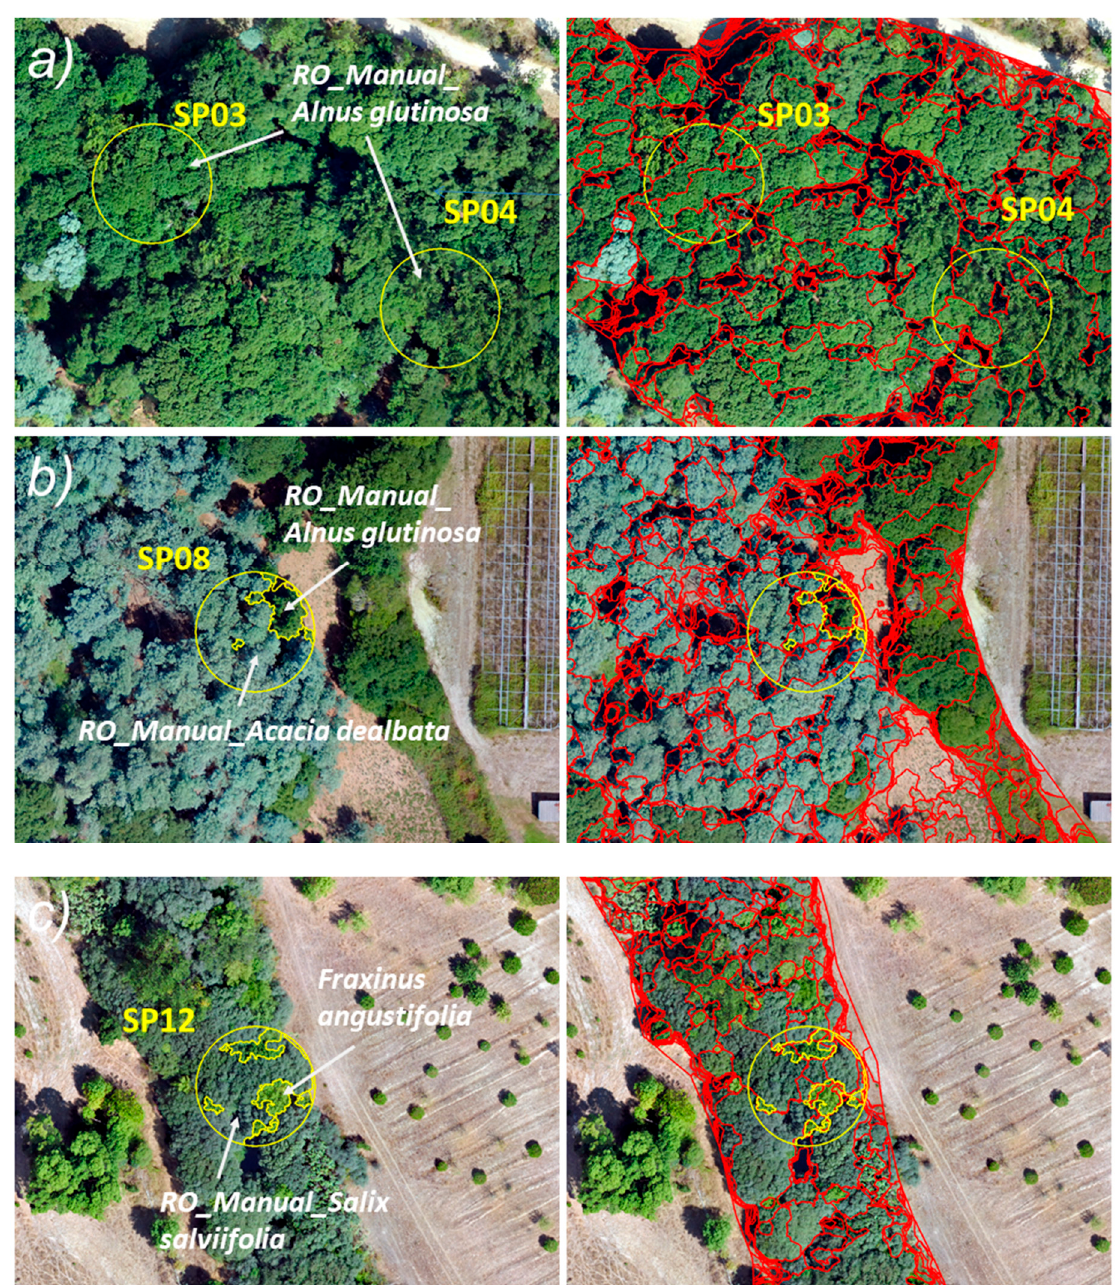
Figure 3. Illustration of the manual digitalization and segmentation phases overlaid in the RGB composite unmanned aerial vehicle (UAV) imagery in: ( a ) the northern part of the riparian forest dominated by Alnus glutinosa , ( b ) the central part of the riparian forest dominated by Acacia dealbata and ( c ) the southern part of the riparian forest dominated by Salix salviifolia . Yellow patches in the left panels represent the field sampling plots with the manual objects visually classified, while red patches, in the right panels, represent the objects automatically produced in the segmentation phase using the Green-Red-NIR image-composite bands.